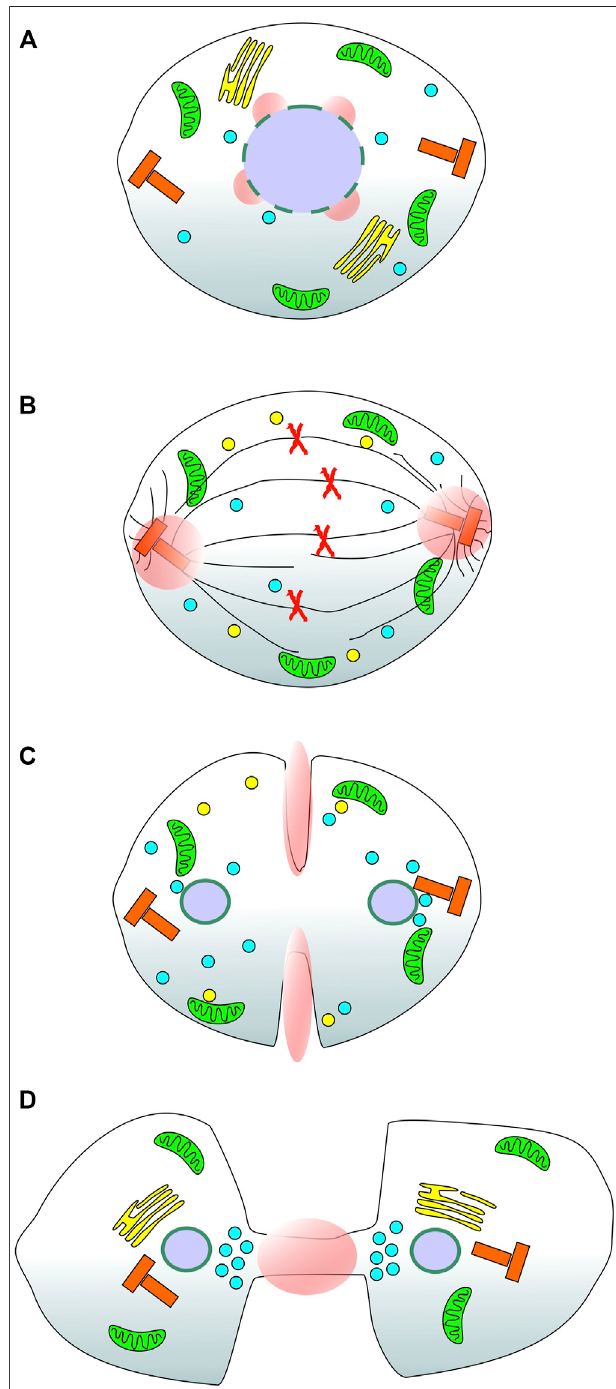
FIGURE 1 | Reported and suspected sites of focal calcium signals during cell division in mammalian cells. A series of cartoons of a stylised mammalian cell as it progresses through mitosis. (A) During prometaphase, the nuclear envelope breaks down in response to a speci fi c calcium signal(pinkspheres); (B) Duringmetaphaseandintoanaphaseafocalcalcium signal appears at both centrosomes of the dividing cell consistent with the dynamic movement of Annexin 11 from the nucleus to the spindle poles; (C) ( Continued